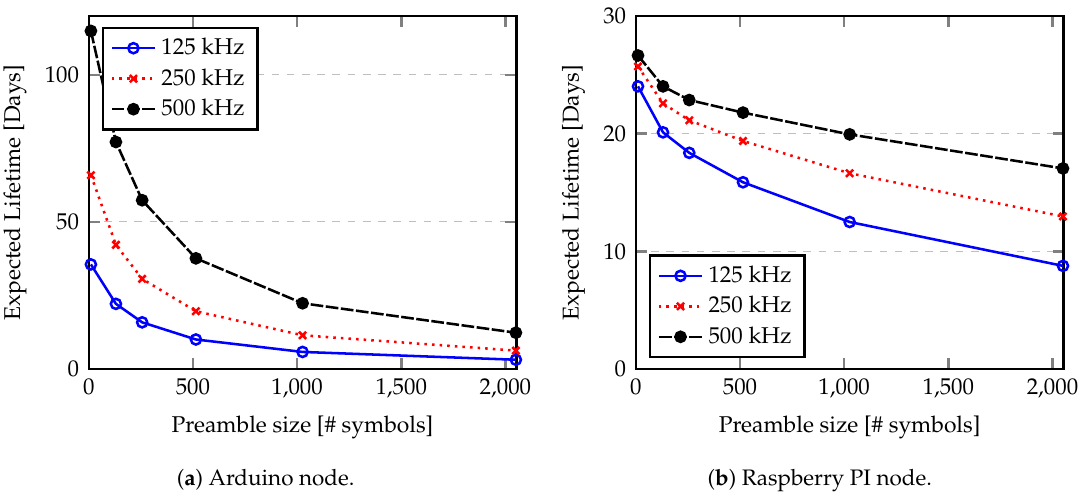
Figure 16. Expected lifetime according to the preamble